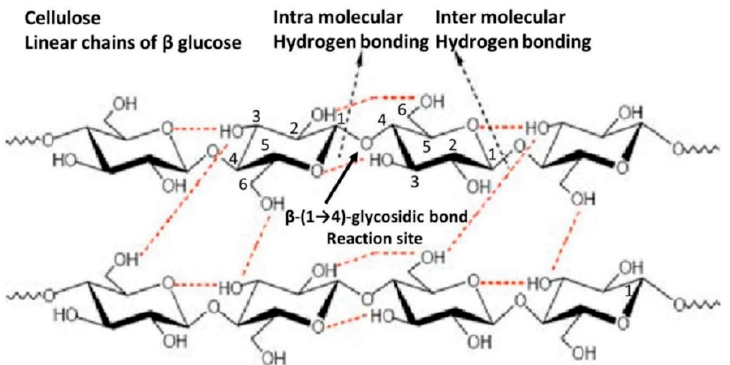
Figure 3. The reaction site β -1,4 glycosidic bond in cellulosic biomass surrounded by extensive hydrogen bonding network. Adapted with permission from Peertechz [71].